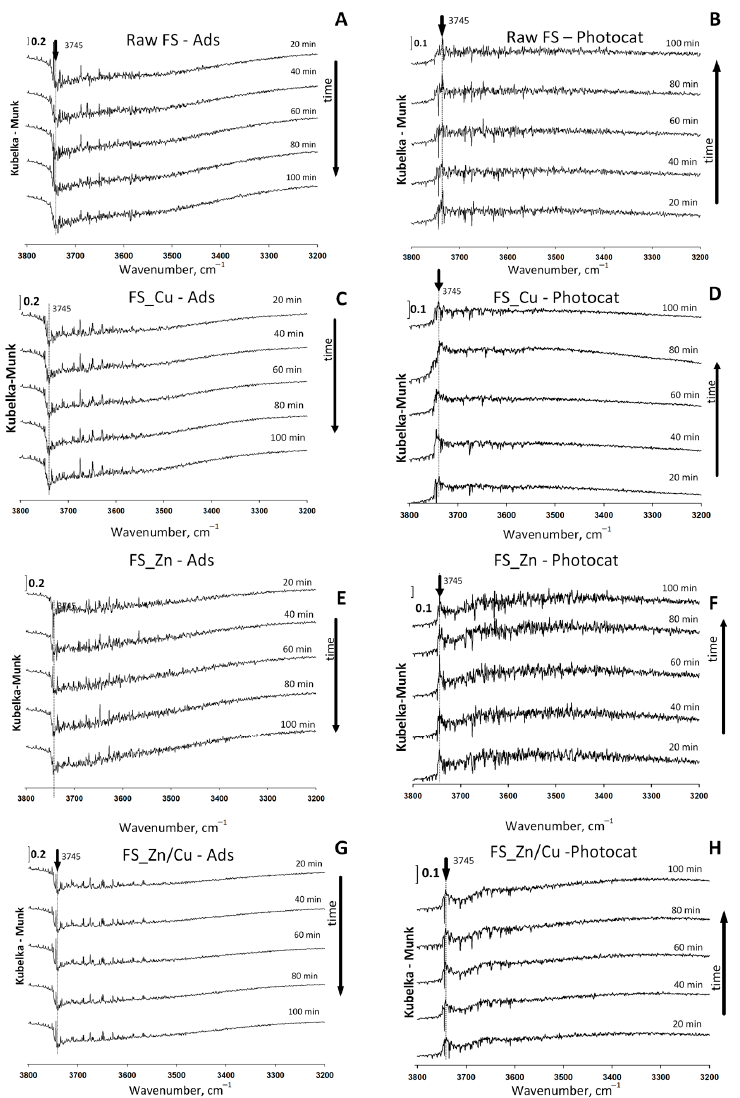
Figure 8. Evolution of subtracted DRIFTS spectra of the OH stretching vibration zone during the adsorption step (left) and photocatalytic degradation step of ethylene (right) onto raw fumed silica. Prepared single and double metal oxide catalysts supported on fumed silica: raw FS ( A , B ), FS_Cu ( C , D ), FS_Zn ( E , F ), and FS_Zn/Cu ( G , H ).